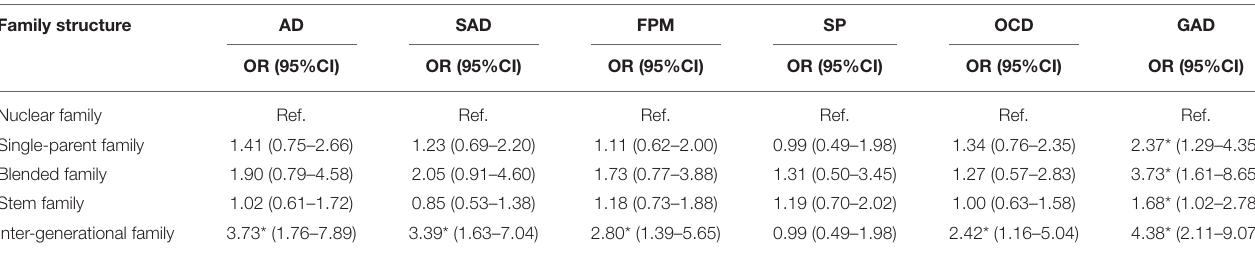
TABLE 3 | Association (OR) between family structure and different disorders by multivariable logistics regression analysis regression among preschoolers. Family structure AD